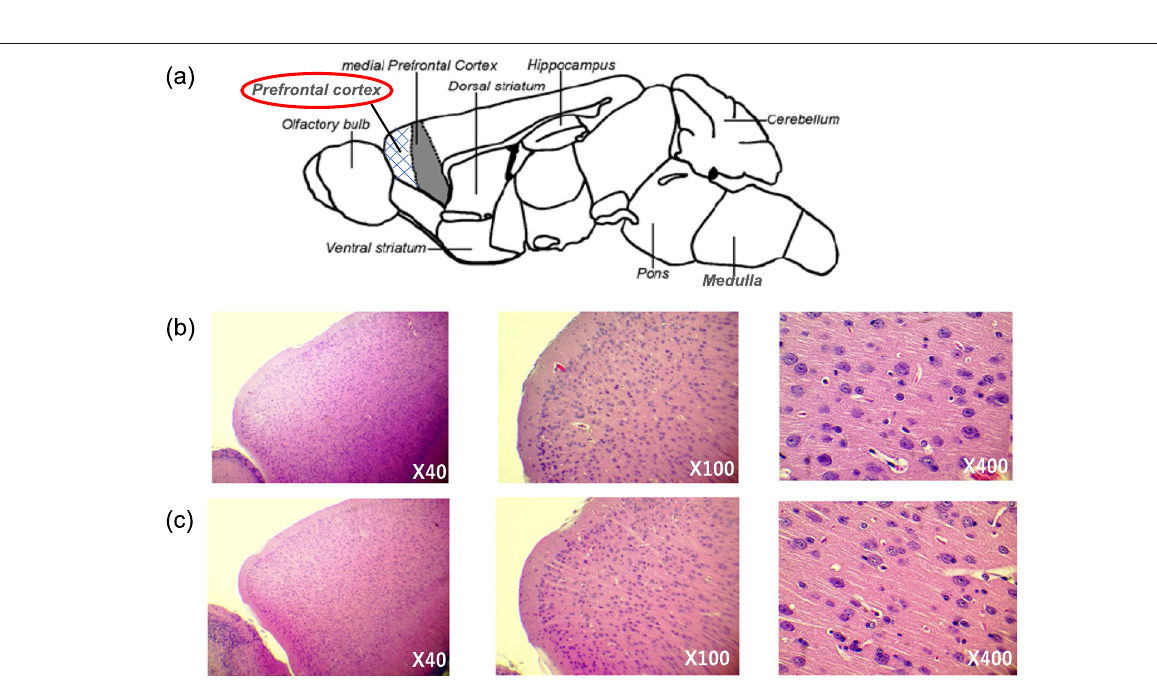
Fig. 4 Mouse brain and representative histological photographs. a Mouse brain regions and prefrontal cortex of b tap water (control) and c tap water containing arsenic exposed 41-week-old F2 male mice. (H&E stain) ( n = 2 –